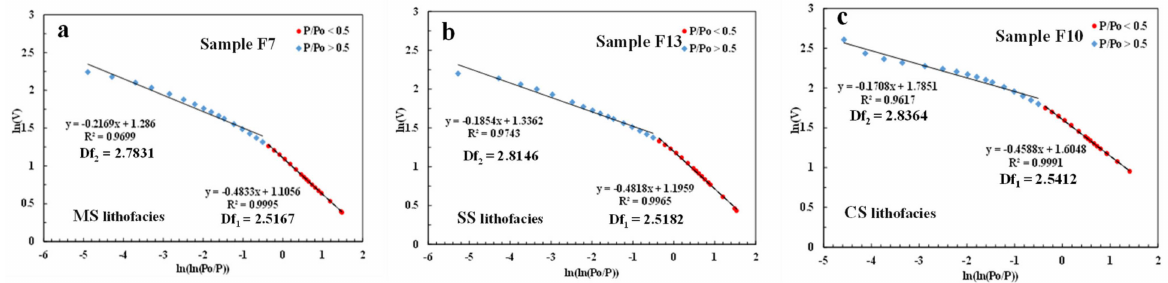
Figure 7. Slopes of ln(V) and ln(ln(P 0 /P)) from the FHH model of N 2 adsorption: ( a ) MS lithofacies; ( b ) SS lithofacies; ( c ) CS lithofacies.